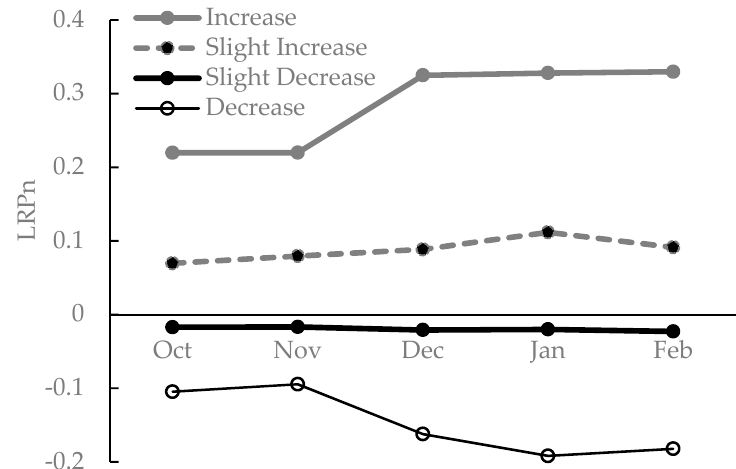
Figure 3. Transition of the median value of log-transformed relative proportions of each cluster for each month after the intervention started.